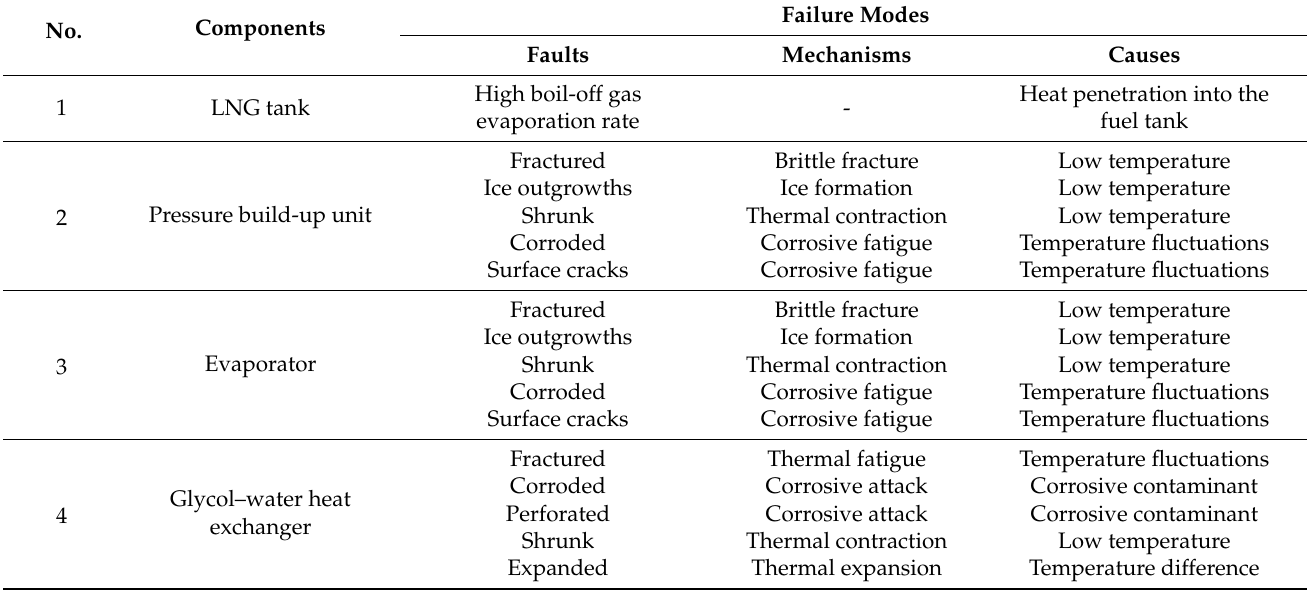
Table 4. Failure modes of system